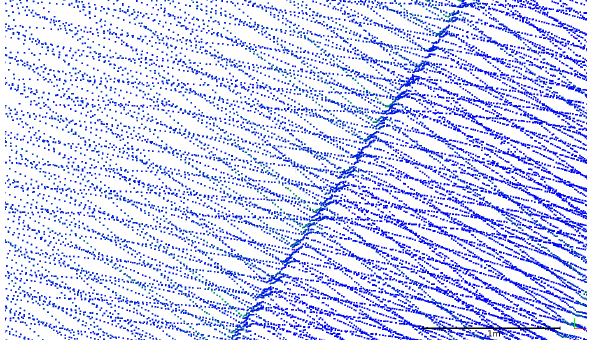
Figure 2: Anisotropic pattern on the ground (color of points is the